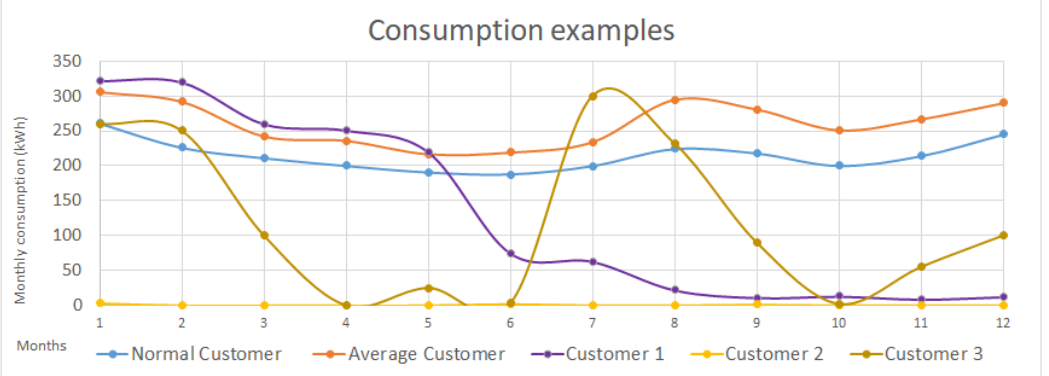
Figure 4. Some examples of different consumption behaviors. The features need to provide enough information to extract as much information as possible from these profiles: Long periods of low consumption (customer 2), abrupt decrease of consumption (customer 1), similar consumption behavior to the expected consumption curve (Normal customer) or an abnormal consumption curve (Customer